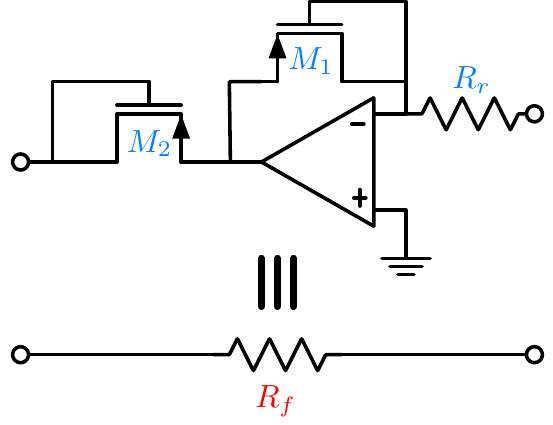
Figure 23. Active implementation of the feedback resistance, R f